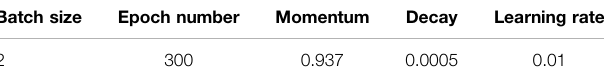
TABLE 1 | Selection of key parameters.